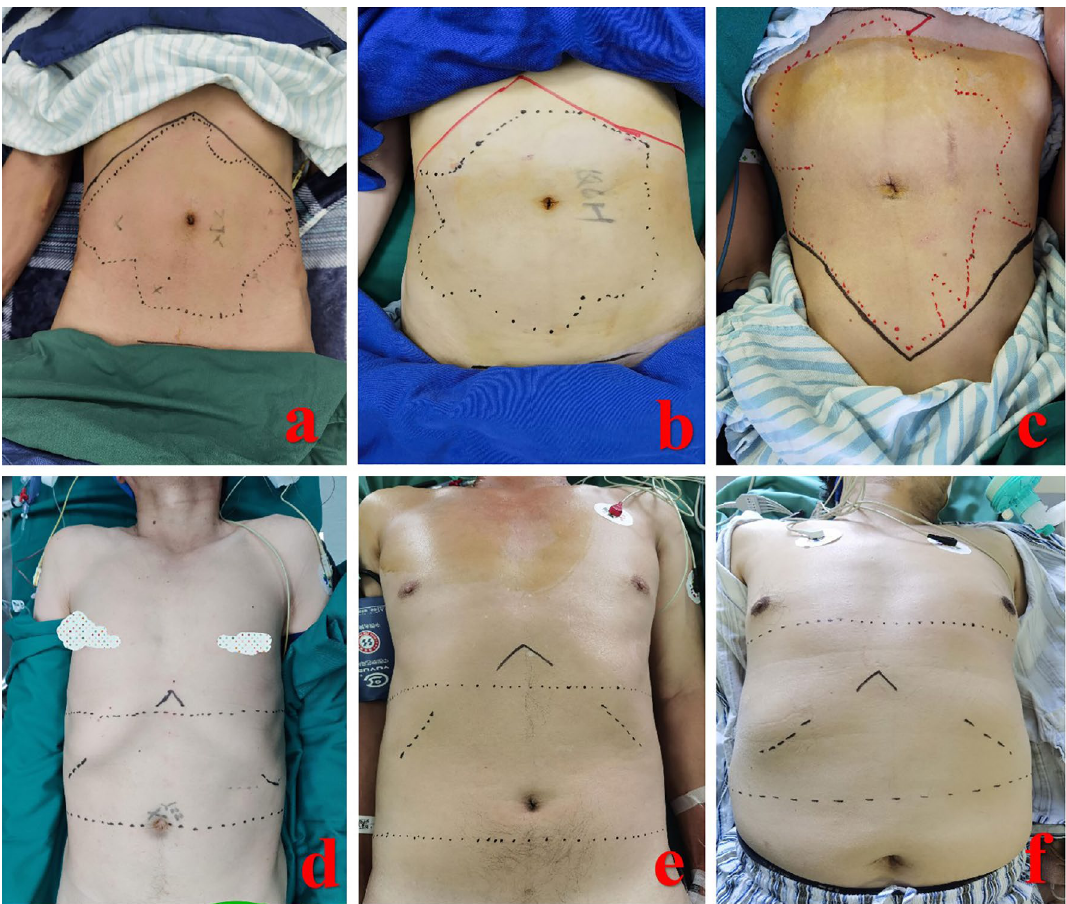
Figure 4. Sensory level of abdominal nerve block and epidural anesthesia with pinprick. ( a – c ) Sensory level of abdominal nerve block under ultrasound guidance; ( d ) epidural anesthesia at T11–T12; ( e ) epidural anesthesia at T12–L1; ( f ) epidural anesthesia at T9–T10.